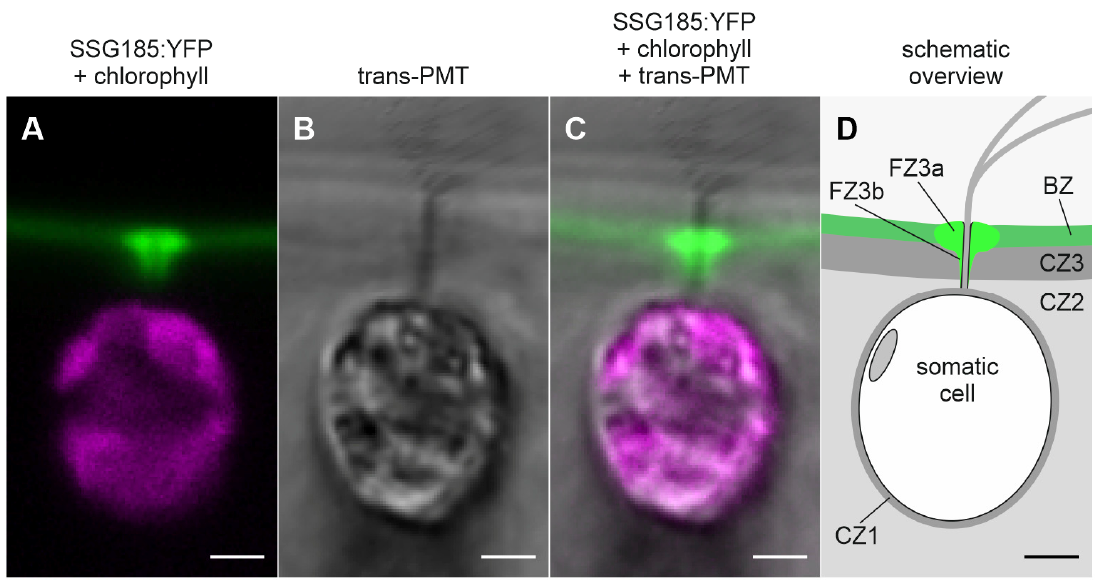
Figure 8. Localization of SSG185:YFP at the flagellar region of the somatic cells. Transformants expressing the ssg185 : yfp gene were analyzed in vivo for the localization of the SSG185:YFP fusion protein. High-magnification CLSM optical cross-section focusing on the flagellar region of somatic cells. Transmission-PMT (trans-PMT) images and a schematic overview are included for orientation. ( A ) Overlay of YFP fluorescence of SSG185:YFP protein (green) and chlorophyll fluorescence (magenta). ( B ) Transmission-PMT (trans-PMT). ( C ) Overlay of SSG185:YFP fluorescence (green), chlorophyll fluorescence (magenta) and transmission-PMT. ( D ) Schematic overview indicating the position of SSG185:YFP and of the involved ECM zones. For unknown reasons, the trans-PMT ( B , C ) shows interference effects that cause extra lines near the surfaces of the spheroid and the flagella. These lines should not be considered. BZ, boundary zone; CZ, cellular zone; FZ, flagellar zone; FZ3a, flagellar hillock; FZ3b flagellar tunnel wall. Scale bars: 2 μ m.